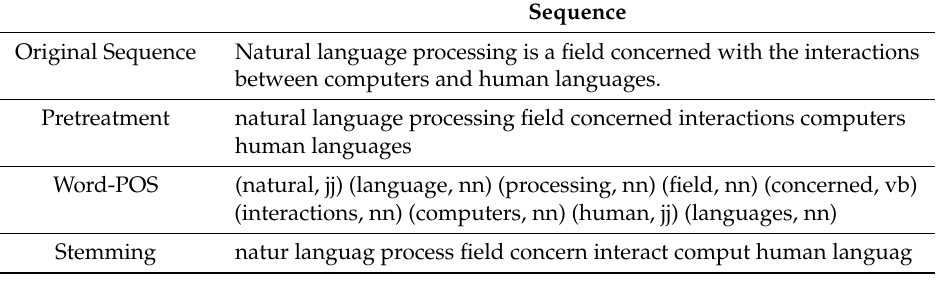
Table 3. Example of Sequence Transformation.